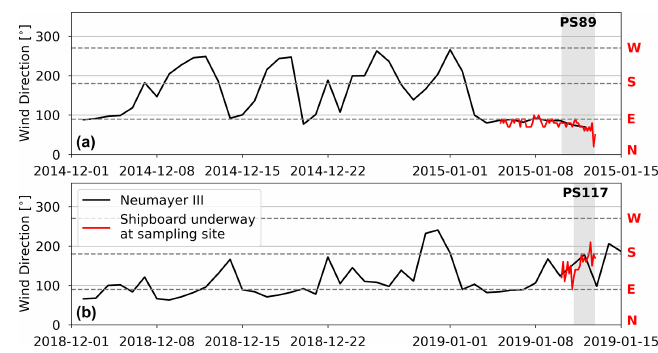
Figure H2. (a) Wind direction measured at Neumayer III Research Station in the time prior to and during the PS89 tidal observation (black), as well as the shipboard wind direction measurements during the PS89 tidal observation (red). (b) Wind direction measured at Neumayer III Research Station in the time prior to and during the PS117 tidal observation (black), as well as the shipboard wind direction measurements during the PS117 tidal observation (red). Grey areas indicate the duration of the tidal observations. Horizontal dashed lines indicate 90, 180, and 270 ◦ . North, east, south, and west directions are indicated by the red initials at the right side of the plots.